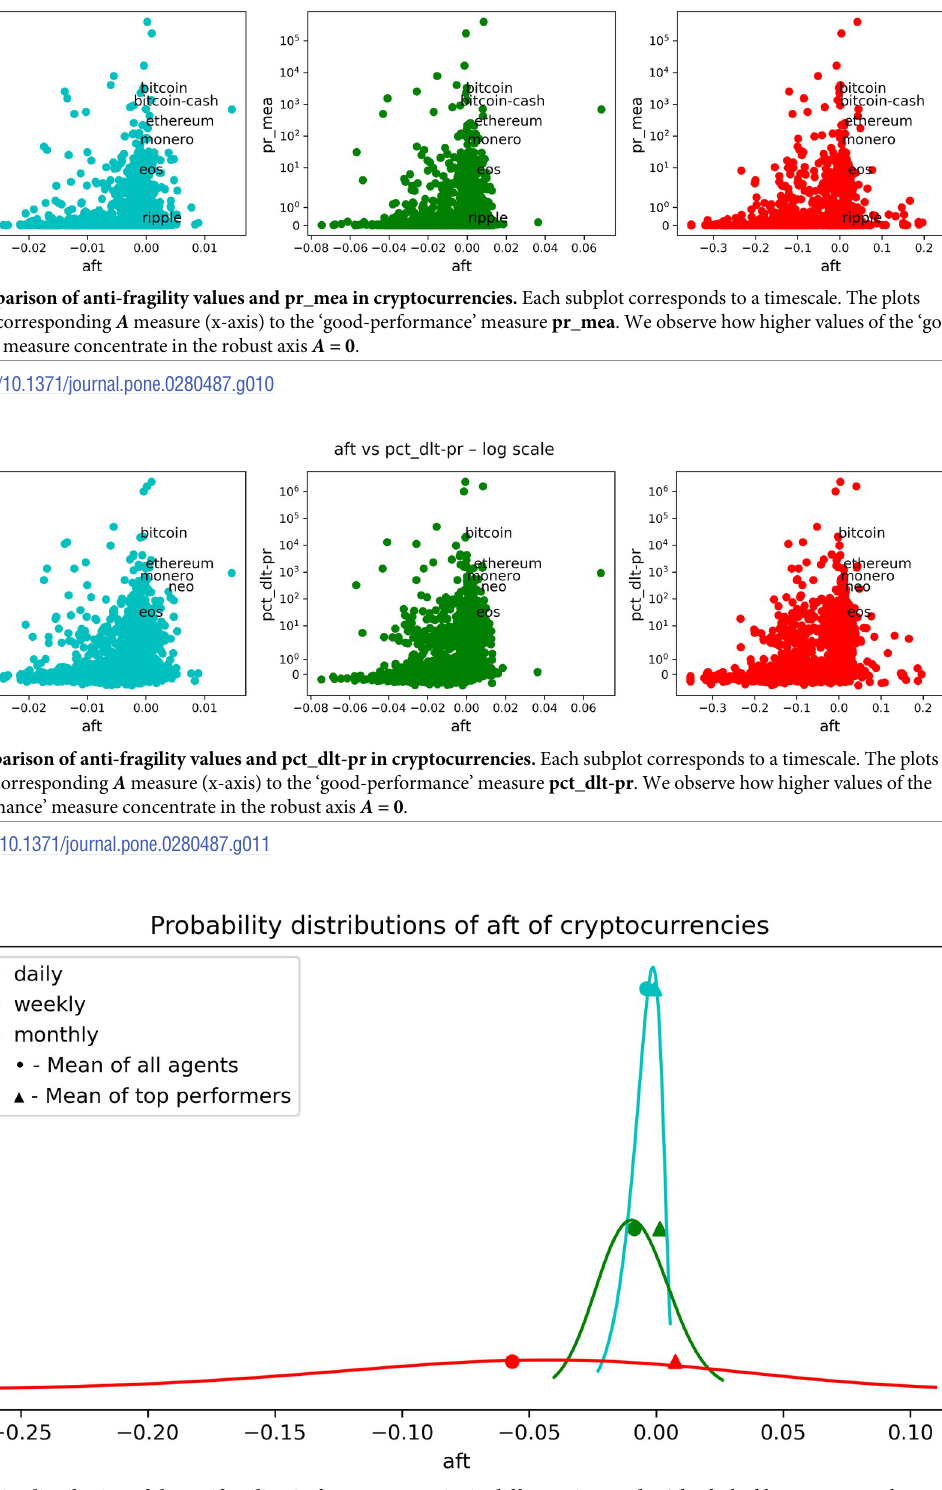
Fig 12. Probability distribution of the antifragility A of cryptocurrencies in different time-scales. The dashed line represents the mean antifragility of the set of ‘top-performers’. We observe that the mean A of ‘top-performers’ is greater than the mean A in every timescale.